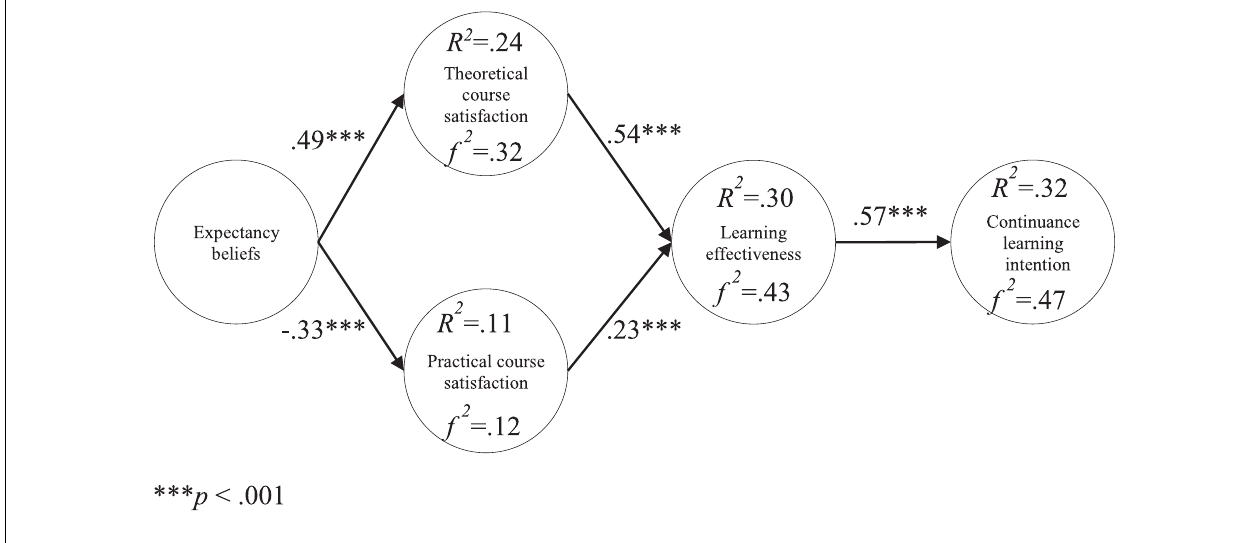
FIGURE 2 | Research model validation. ∗∗∗ p <